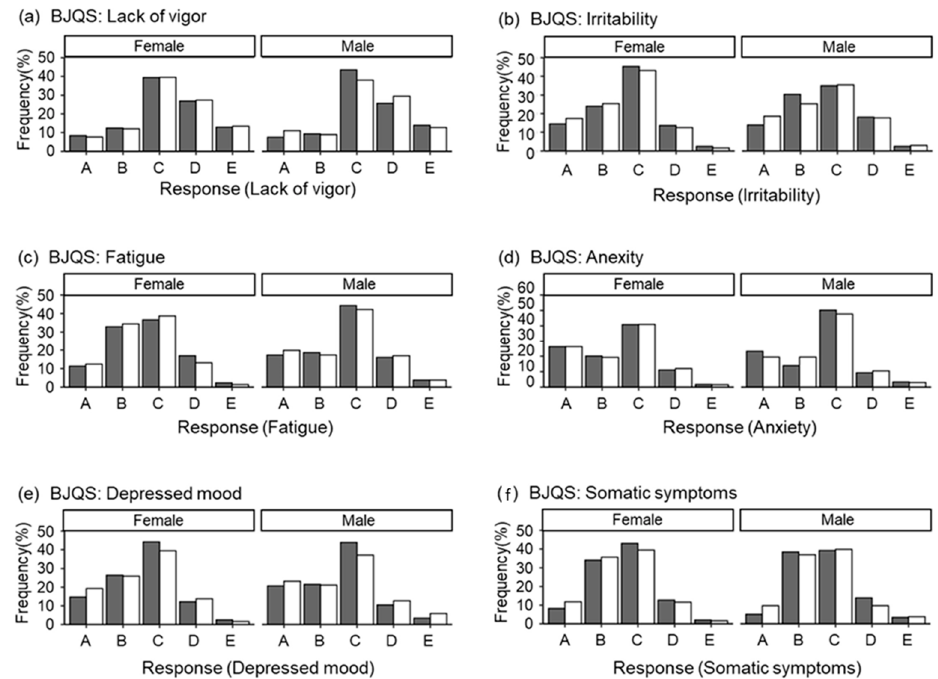
Figure 2. The Brief Job Stress Questionnaire. Gray: summer; white: winter. ( a ) Responses (lack of vigor), ( b ) responses (irritability), ( c ) responses (fatigue), ( d ) responses (anxiety), ( e ) responses (depressed mood), and ( f ) responses (somatic symptoms). x -axis—A: mild, B: slightly mild, C: normal, D: slightly severe, E: severe. y -axis—frequency of subjects (%).